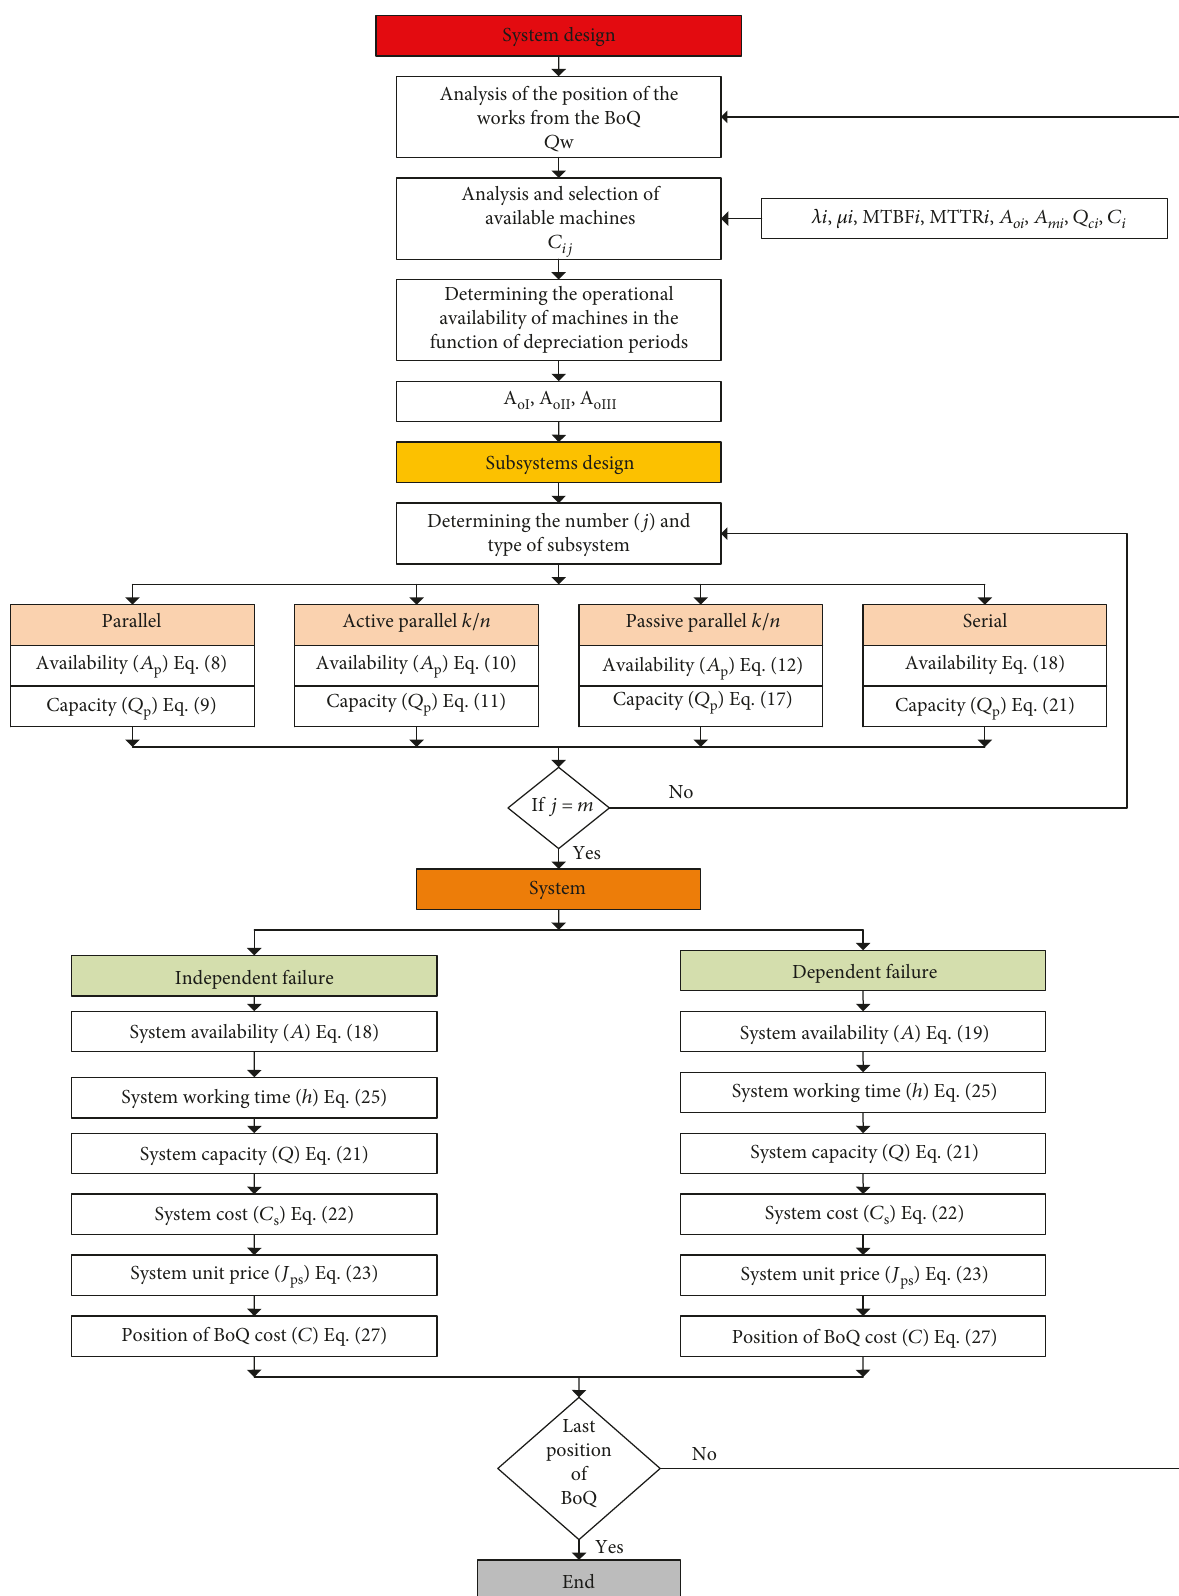
Figure 2: Block diagram/procedure of the proposed